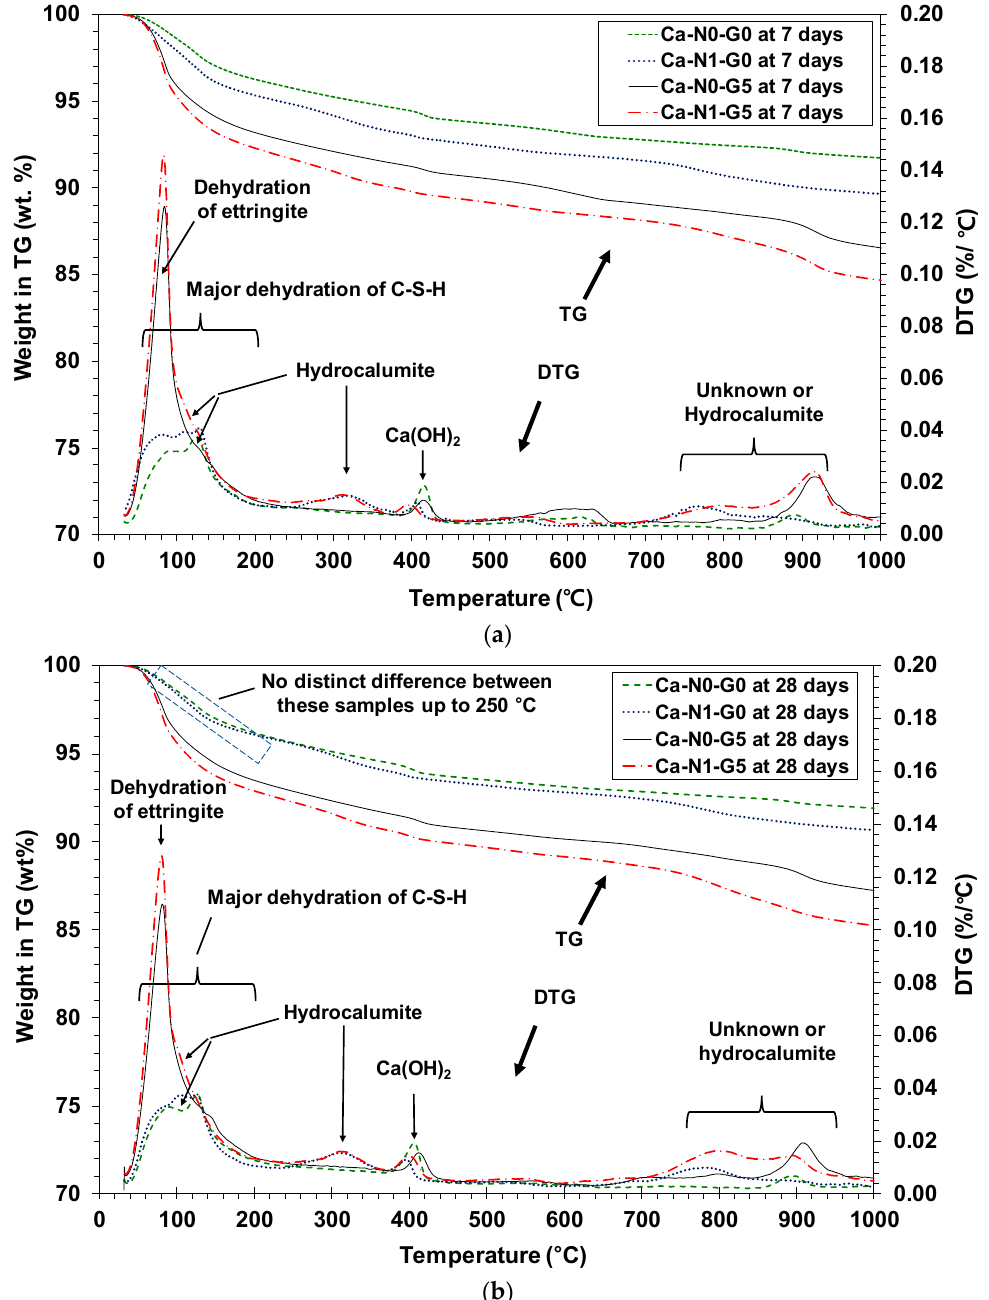
Figure 4. Thermogravimetry (TG) and differential thermogravimetry (DTG) results of hardened samples at ( a ) 7 and ( b ) 28 days.